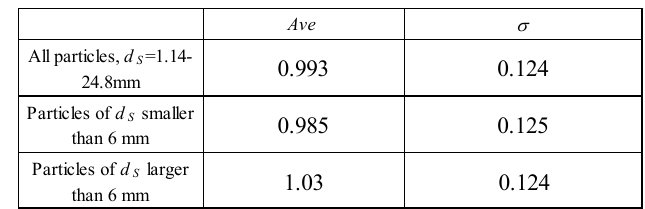
Table 2 Comparison of estimated and measured volume fraction < α